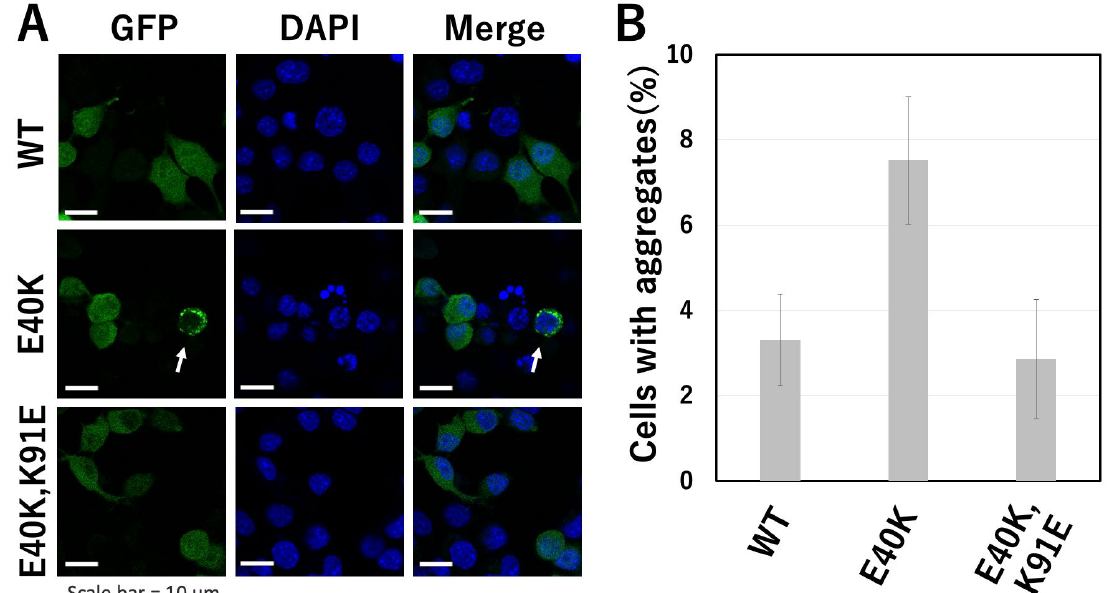
Figure 4. The aggregate formation in transfectants of GFP-tagged cSOD1s. ( A ) Confocal micrographs of GFP-tagged cSOD1. Aggregates, which were observed as bright spots, were shown by a white arrow. ( B ) The proportion of cells containing cSOD1